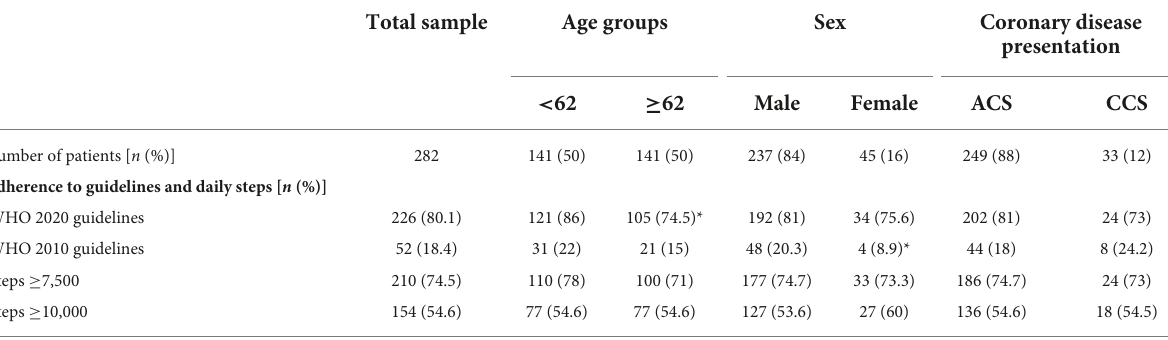
TABLE 2 Results of adherence to guidelines and steps per day according to age, sex, and disease